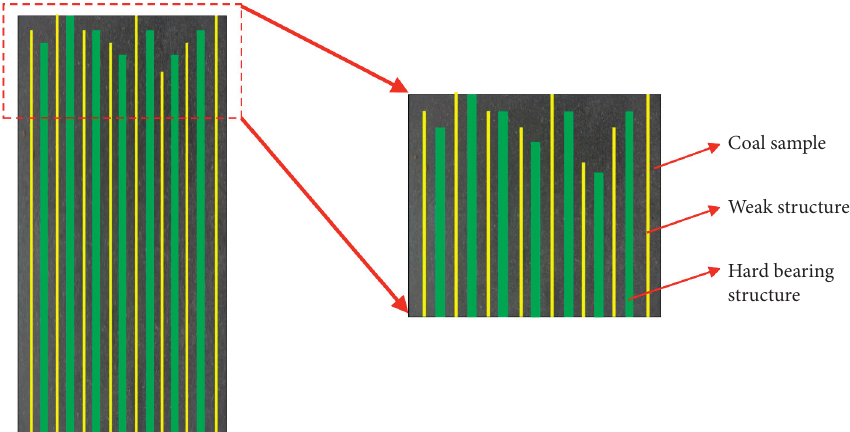
Figure 10: Failure model of sample